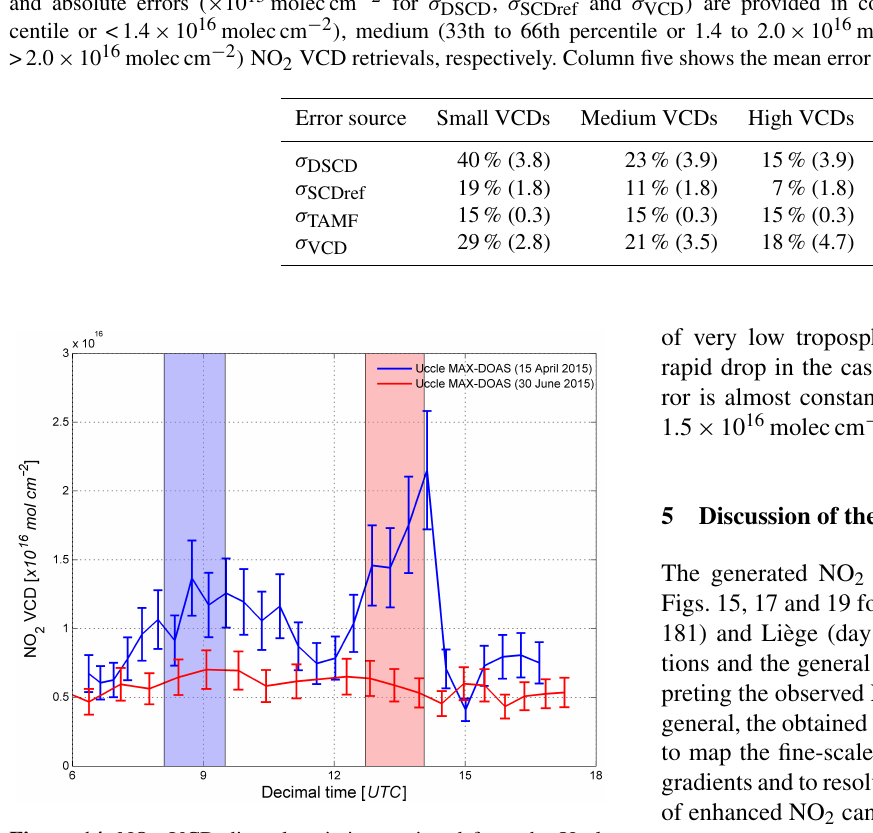
Figure 14. NO 2 VCD diurnal variation retrieved from the Uccle MAX-DOAS station on 15 April and 30 June 2015. The blue and red columns indicate the flight times on April 15 over Antwerp and on June 30 over